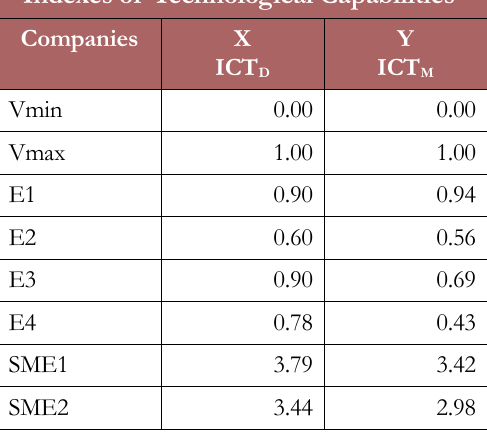
Table 2. Technological Capabilities Indexes of surveyed